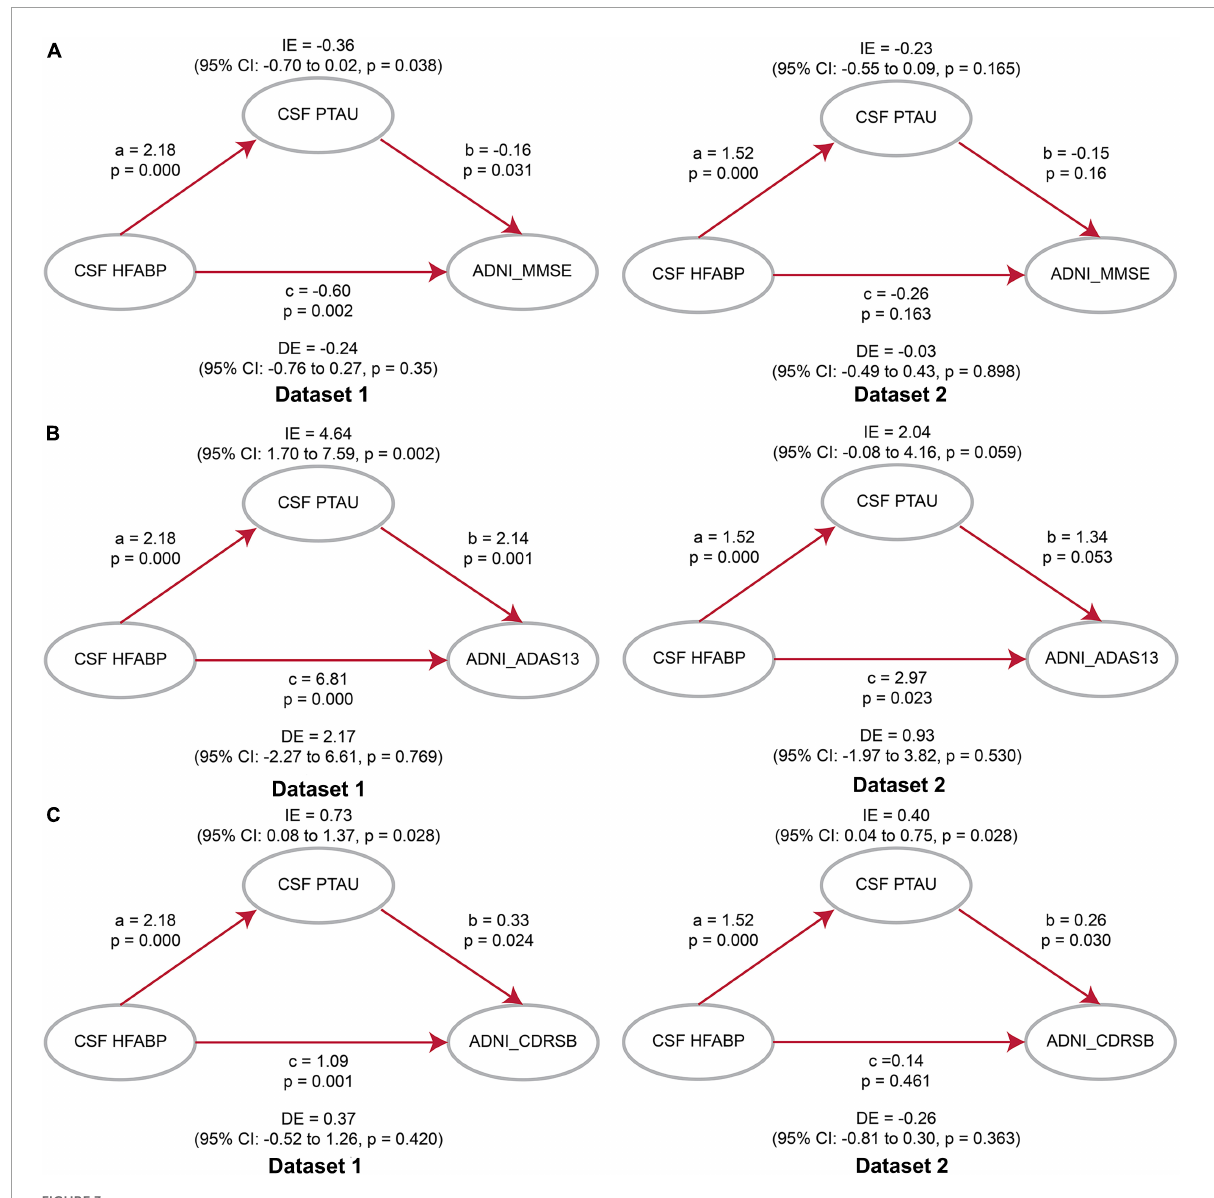
FIGURE3 Mediation analyses showed that the relationship between heart fatty acid-binding protein (HFABP) and cognitive measures were mediated by tau pathology. (A) Global cognition measured by Mini-Mental State Examination (MMSE); (B) global cognition measured by ADAS13; (C) global cognition measured by CDRSB. MMSE, Mini-Mental State Examination; CDRSB, Clinical Dementia Rating sum of boxes; ADAS13, the cognitive section of Alzheimer’s Disease Assessment Scale; ABETA, Amyloid beta; P-tau, phosphorylated tau; IE, Indirect effects; DE, Direct